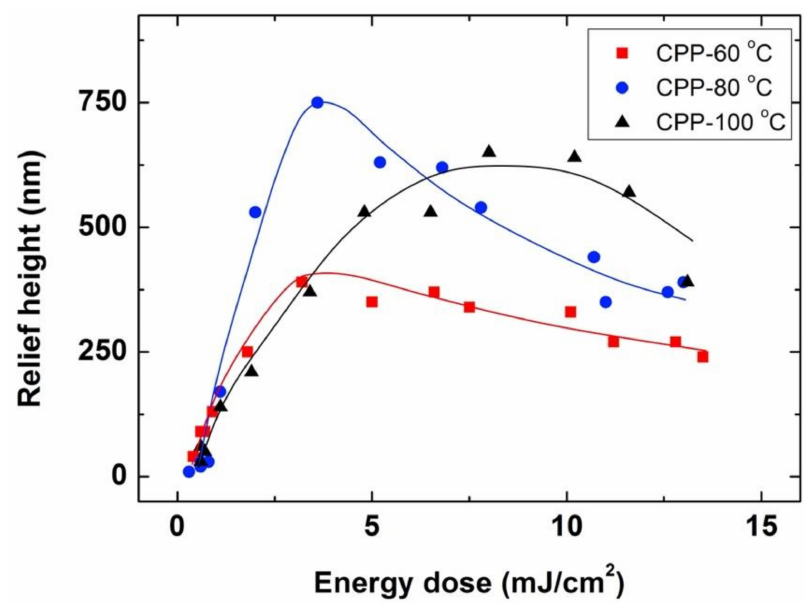
Figure 2. Conventional photoembossing protocol (CPP) comprising an exposure step at RT using IL (single pulse exposure and 9 μ m period grating), followed by a heating step to high temperature. Relief height as a function of energy dose for different temperatures: 60 °C ( ), 80 °C ( ) and 100 °C ( ). Lines are drawn to guide the eye.